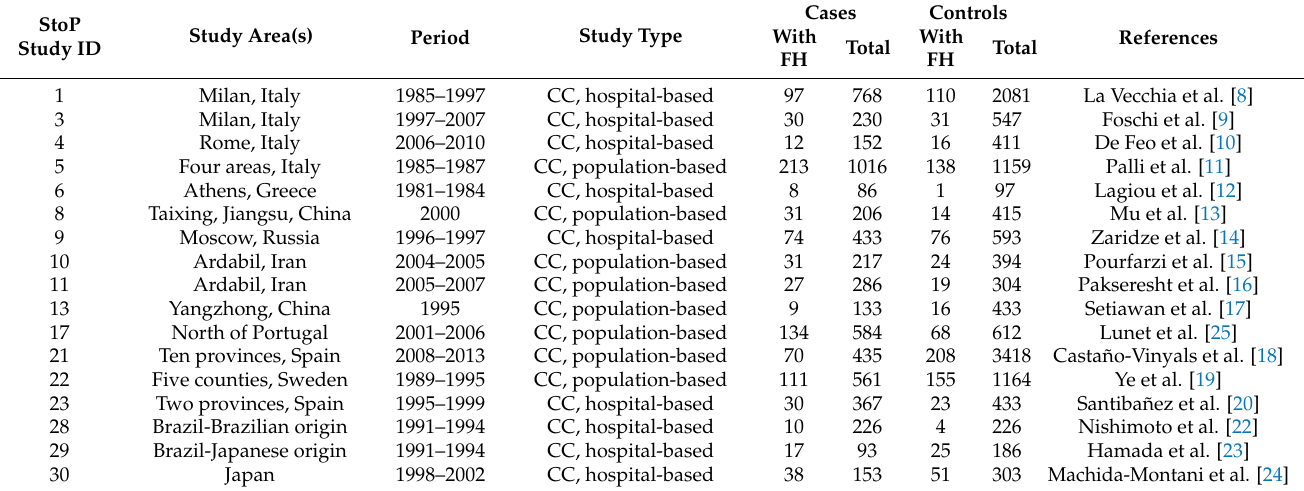
Table 1. Main characteristics of the StoP Project studies included in the analyses.